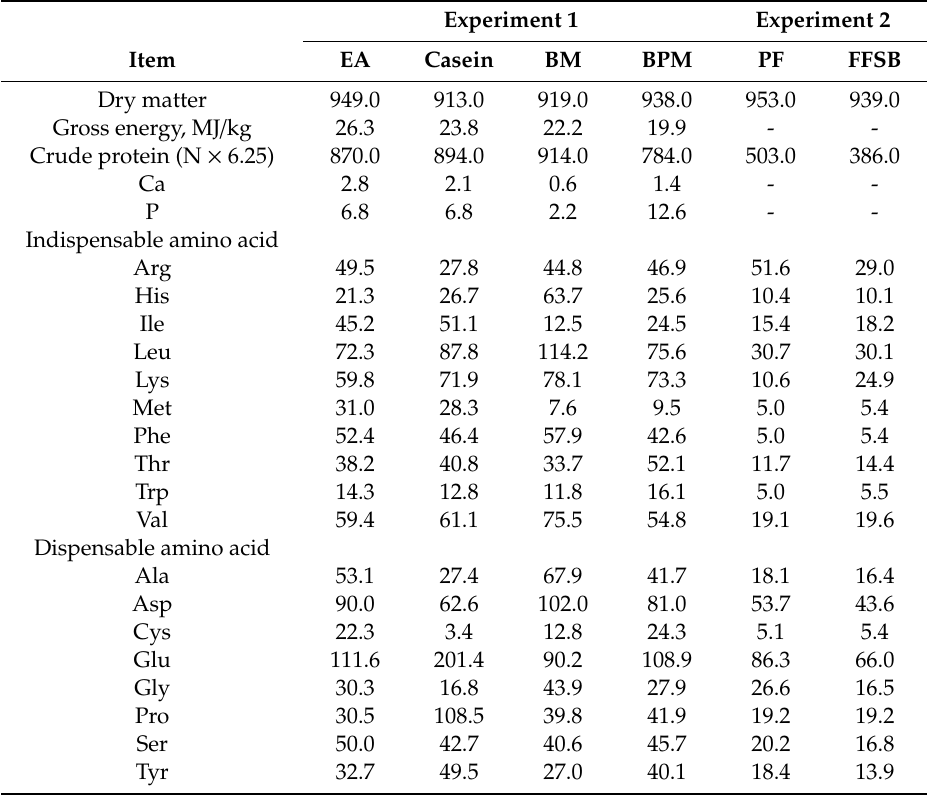
Table 2. Analyzed nutrient composition of test ingredients, g / kg as-fed basis 1